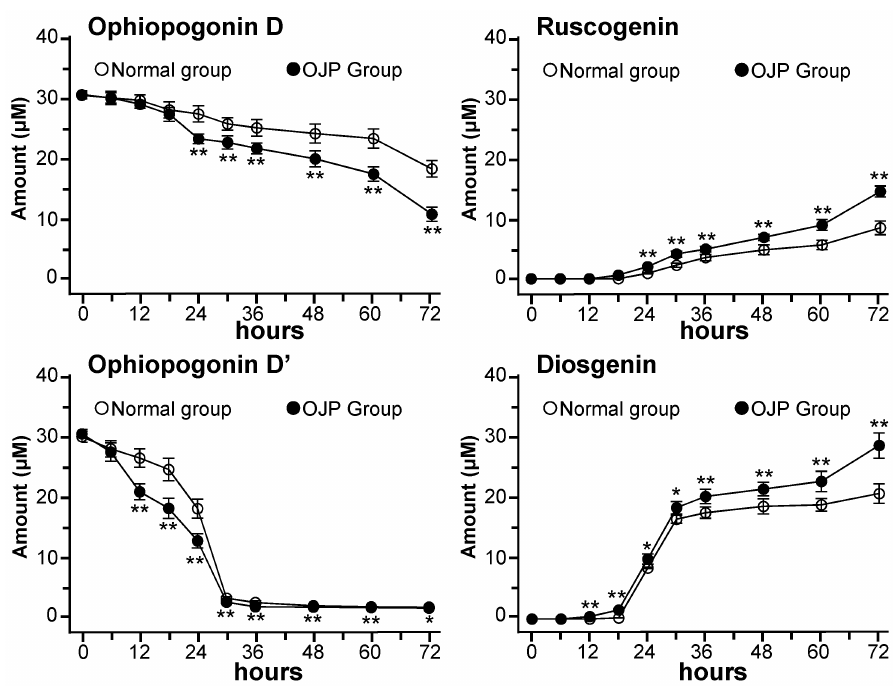
Figure 2. Ophiopogon polysaccharide promotes the metabolism of ophiopogonin D and ophiopogonin D’, as well as the production of ruscogenin and diosgenin. Time-profile elimination / formation of ophiopogonin D, ruscogenin, ophiopogonin D’ and diosgenin in di ff erent conditions. Normal: ophiopogonin group; OJP: Ophiopogon polysaccharide (OJP) + ophiopogonin group. Data are represented as mean ± SD ( n = 5). Significance di ff erence was assessed by one-way ANOVA: * p < 0.05 and ** p < 0.01 vs. normal